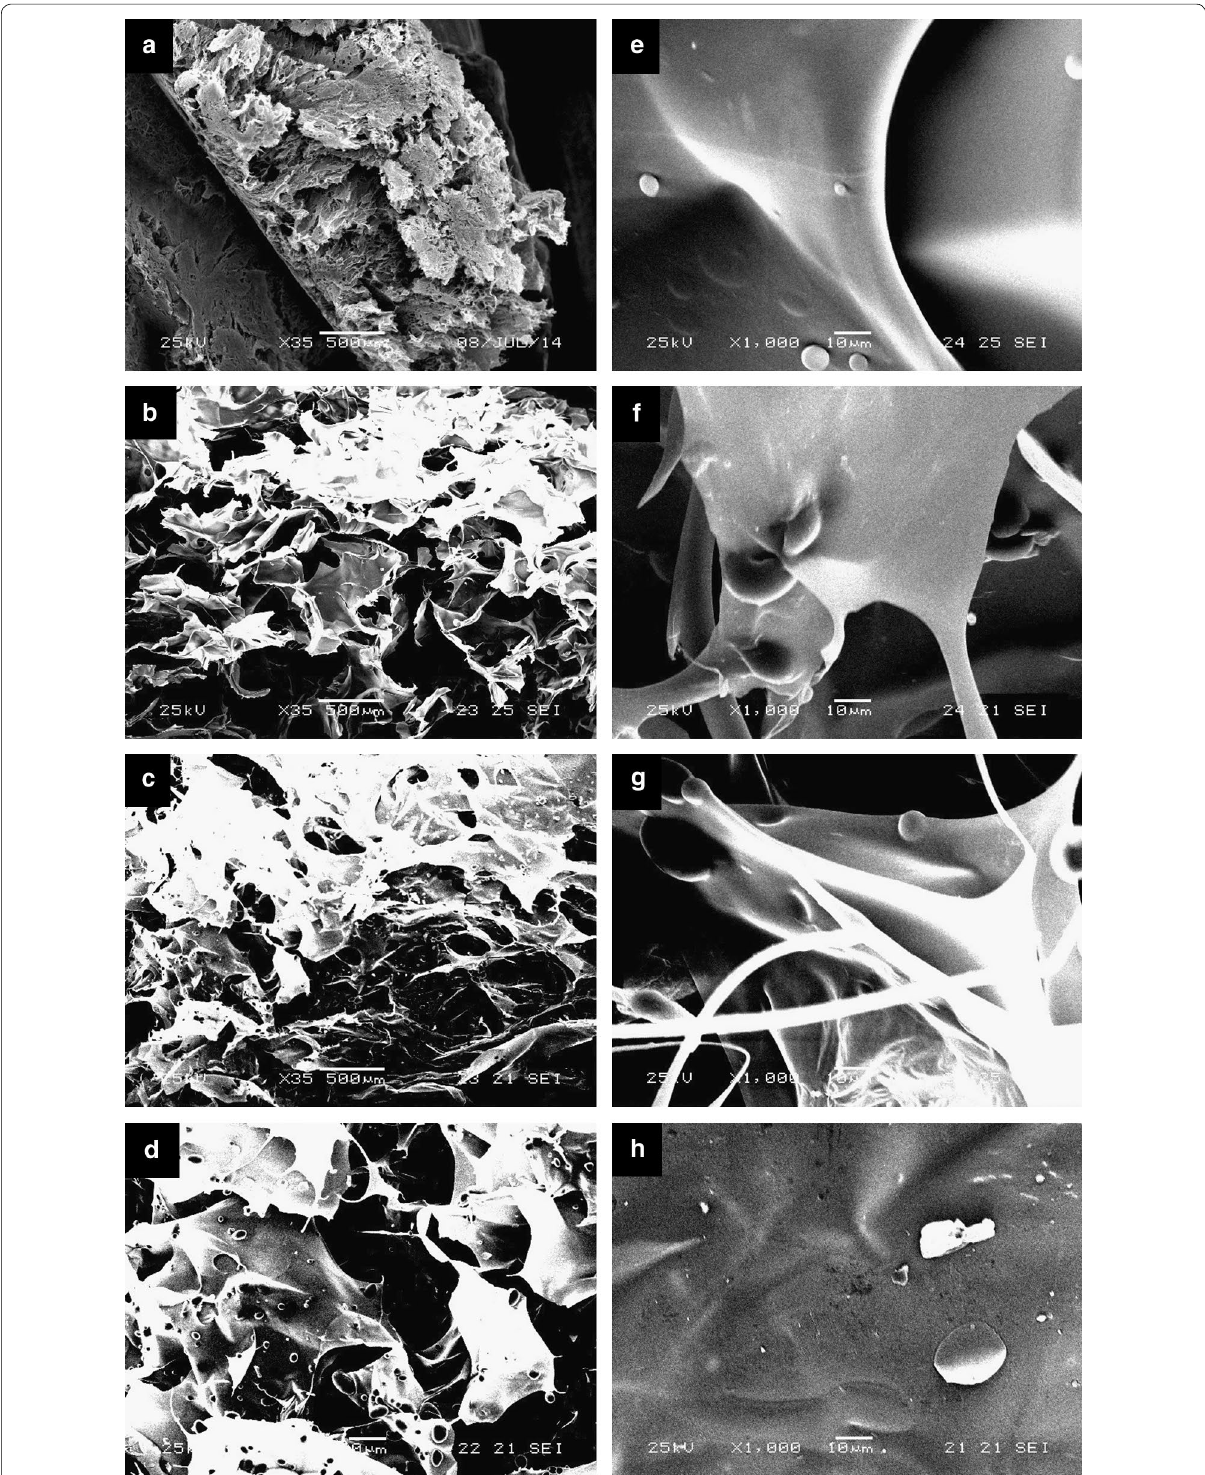
Fig. 2 SEM photographs of freeze-dried CMC/starch hydrogels with a starch content of 0% a , 30% b , e – h and 50% c , d ( synthesis: 20 w/w% solution, 20 kGy